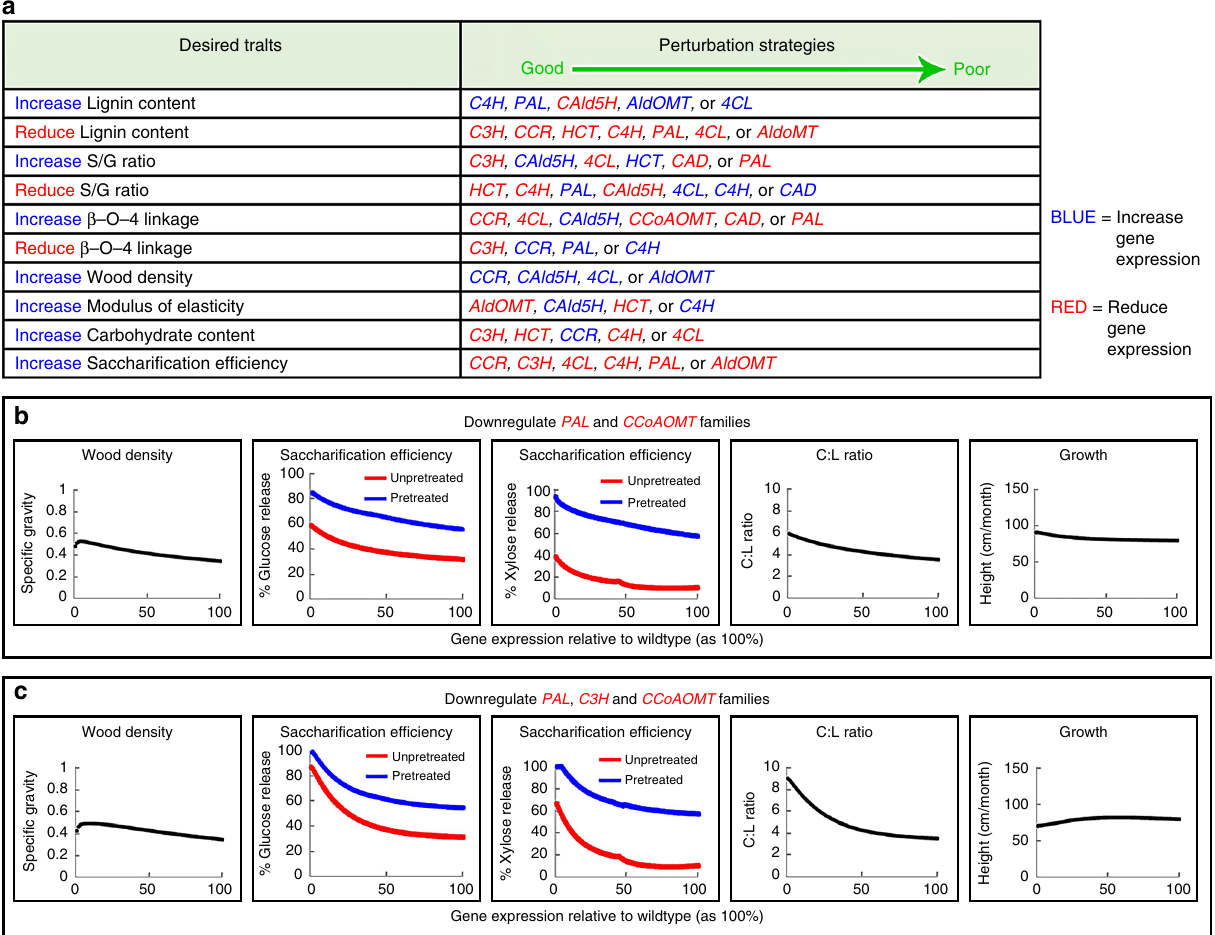
Fig. 10 Strategic engineering of single or combinations of multiple lignin and wood traits through manipulating the expression of speci fi c monolignol genes or combinations of these genes. a The integrative analysis based gene perturbation strategies to achieve speci fi c desired wood traits. Perturbation strategies for each desired trait are arranged from the most signi fi cant effector to the least. Blue text represents increased gene expression, and red text represents reduced gene expression. b , c Examples of integrative analysis predicting how to simultaneously improve a combination of three key wood properties without signi fi cant impact on plant growth — downregulating two gene families ( PtrPAL and PtrCCoAOMT ) ( b ) or downregulating three gene families ( PtrPAL , PtrC3H , and PtrCCoAOMT ) ( c ). Each scatterplot is composed of 100 data points, representing 1 to 100% of wildtype transcript